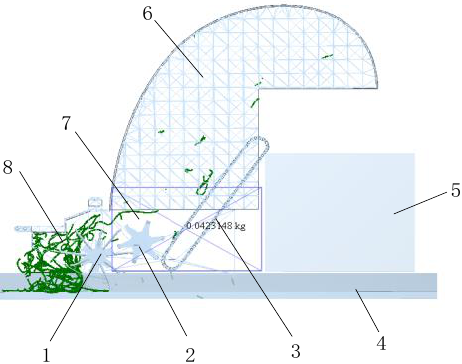
Figure 8. Schematic diagram of simplified simulation model: 1. vine picking device; 2. vine killing device; 3. transporting device; 4. sweet potato ridge; 5. vine collecting box; 6. shield; 7. total mass sensor; and 8. DEM of sweet potato vine.